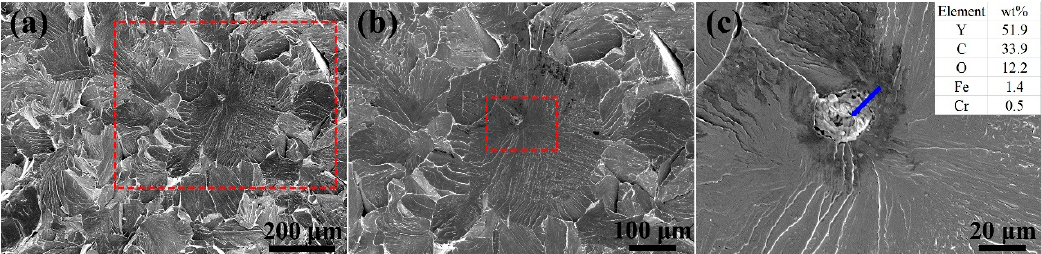
Figure 7. SEM secondary electron micrographs of the fractography for the tensile tested sample: ( a ) macro-morphology; ( b , c ) micrographs of the crack source surface of the as-HIPed alloy A at a high magnification.